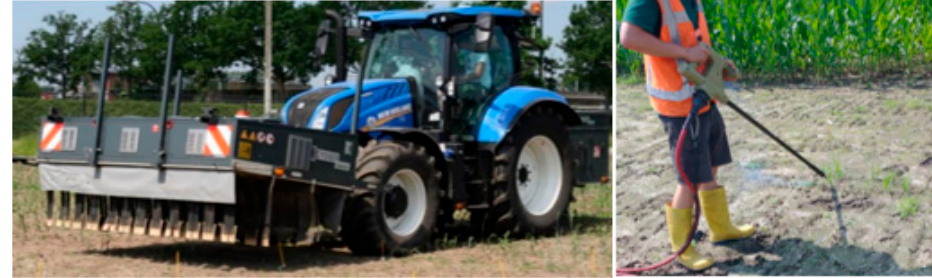
Figure 1. Picture of the Zasso XP300 Xpower (left) and Rootwave Pro (right) electric weeding devices. In the Rootwave experiment, electrocution was performed with a Rootwave Pro (Root- wave Pro-001-2, Ubiqutek ® , Kineton, United Kingdom), from hereon in named ‘Rootwave’ (Figure 1). The machine consists of a power module and alternator, a hand-operated treatment lance (1.5 m long) and a treatment return. The generator produces an alternating current of 230 V (power output between 7.5 kVA and 10 kVA, 50–60 Hz), which is transformed by the power module into high voltage electricity. This current is then transported to the hand-op- erated treatment lance. The voltage delivered by this treatment lance is adjustable: 3000, 4000, or 5000 V. The alternating current (1.5 A) flows through the plant and soil to the treatment return (grounding electrode) which is inserted into the ground at a distance of 10 m from the treated plants. The recommended voltage and treatment duration (varies from 1 to 10 s) de- pends on the weed stem diameter and the weed height (before treatment, trimming might be useful in very dense weed areas for safety reasons). In order to operate safely, dielectric insulating knee boots are needed [25,26].